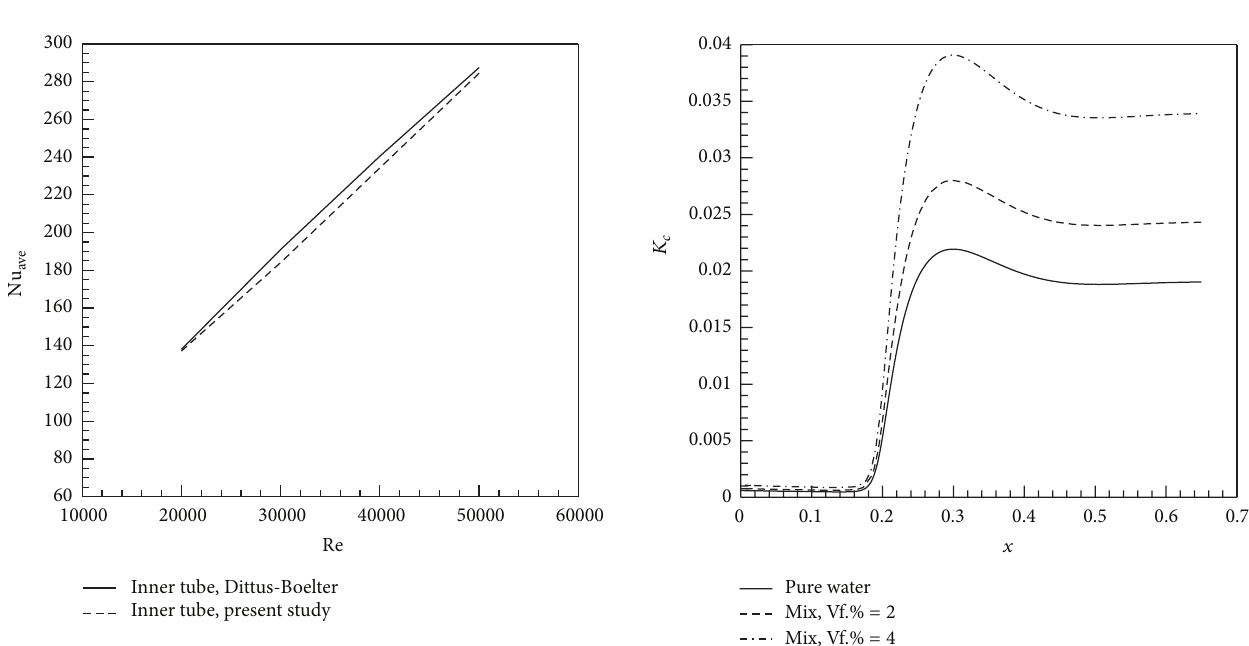
Figure 3: Grid validation for inner tube and annulus by correlation proposed by Dittus and Boelter [16]. Figure 4: Centerline turbulent kinetic energy for different nanopar-